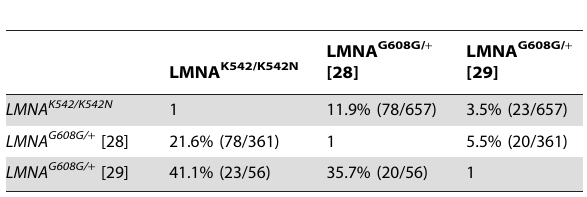
Table 1. Overlap between LMNA K542N and G608G expression